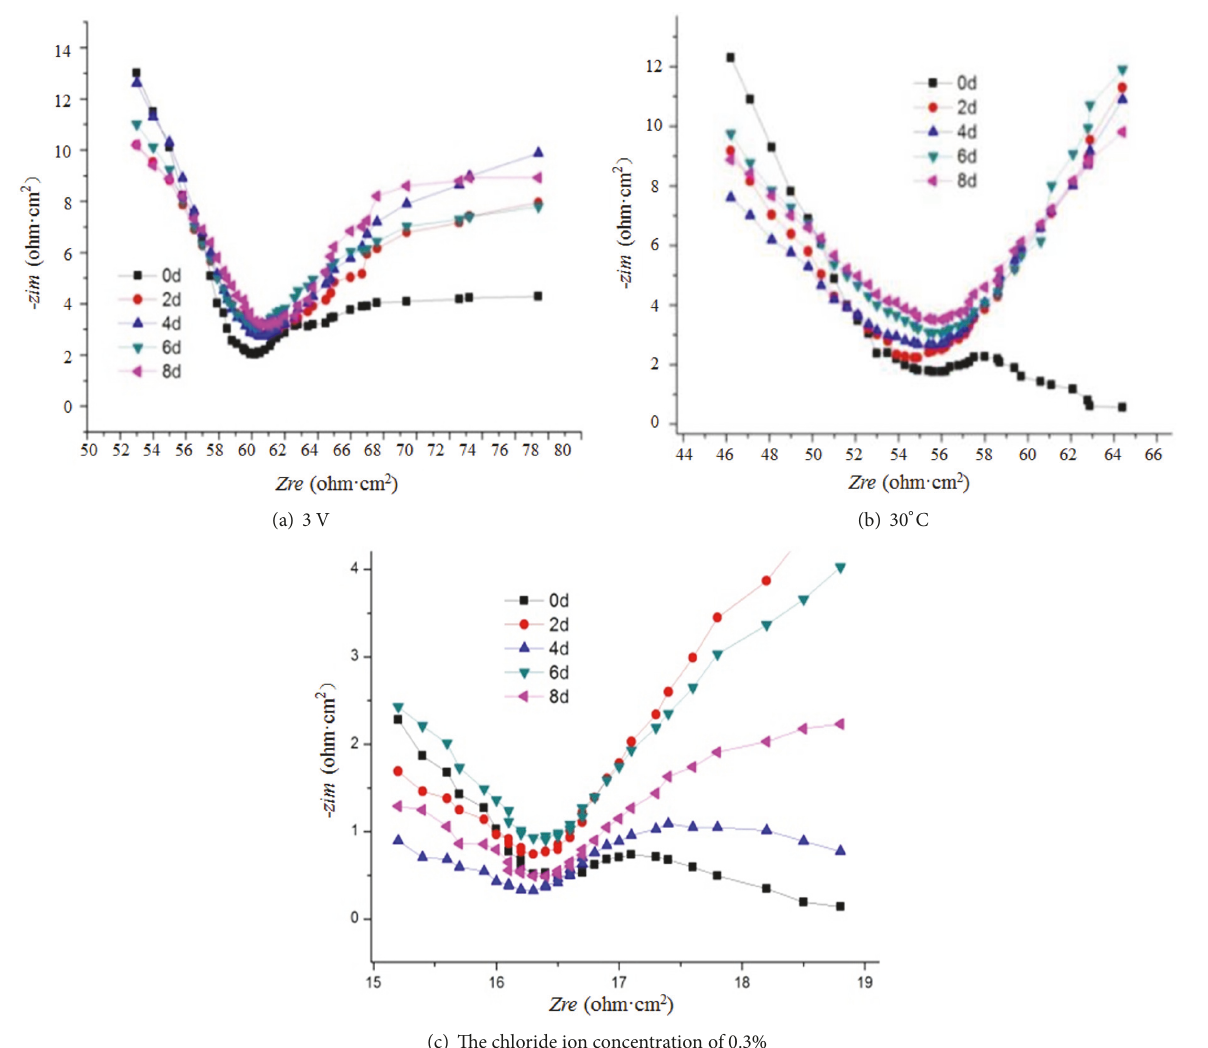
Figure 3: Electrochemical impedance spectra of the sacrificial anode with different influence factors.